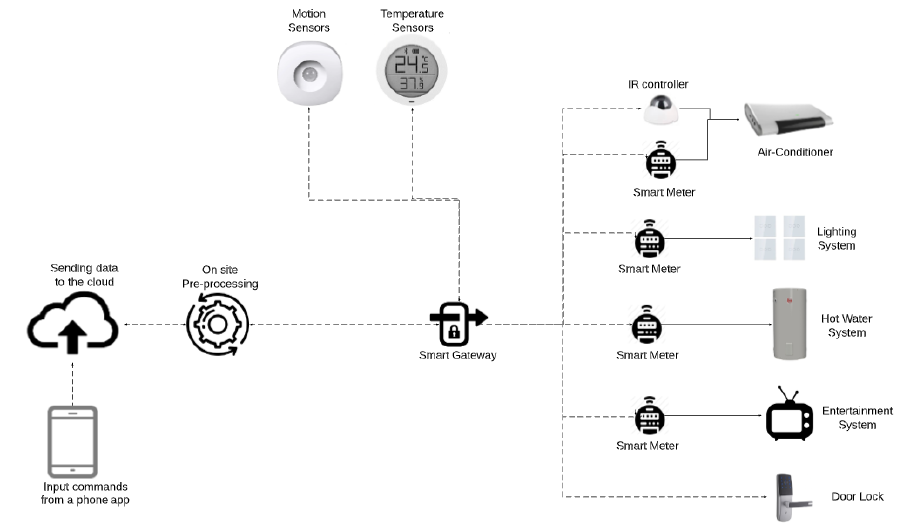
Figure 3. The on-site layout of devices and smart